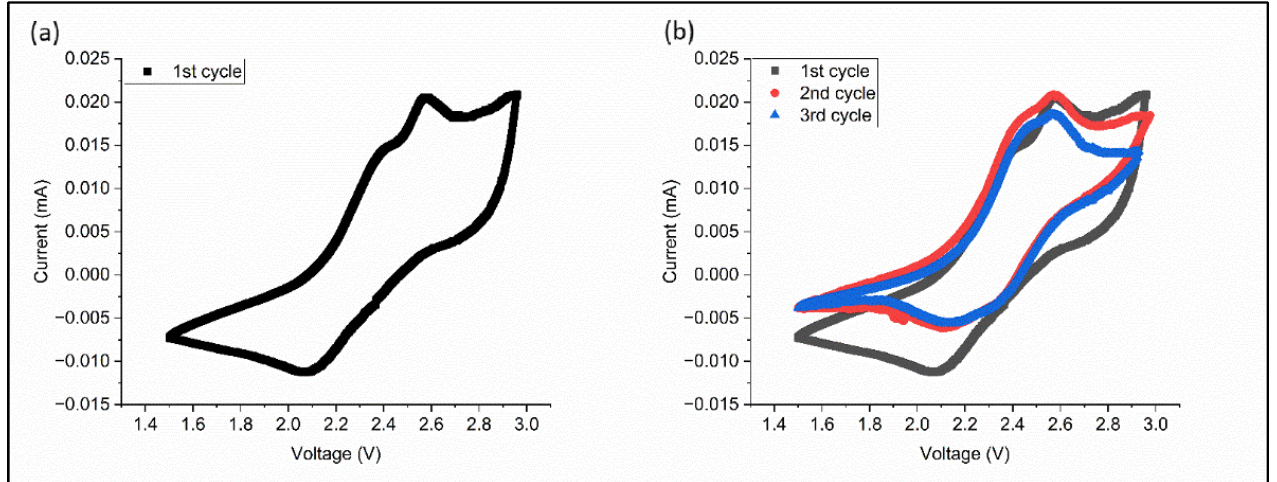
Figure 5. Cyclic voltammogram of the SPNWL, Ni/W = 1:1 battery at a scan rate of 0.1 mV/s. ( a ) First cycle. ( b ) First, second, and third cycles.